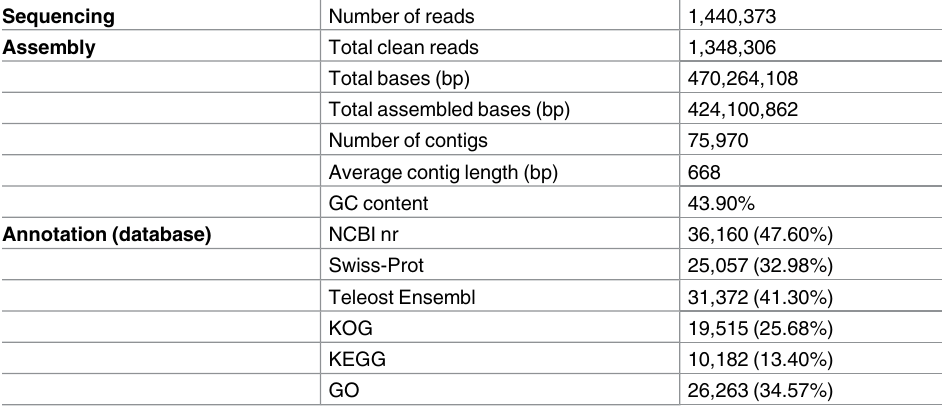
Table 1. Statistical summaryof sea trout skin transcriptome